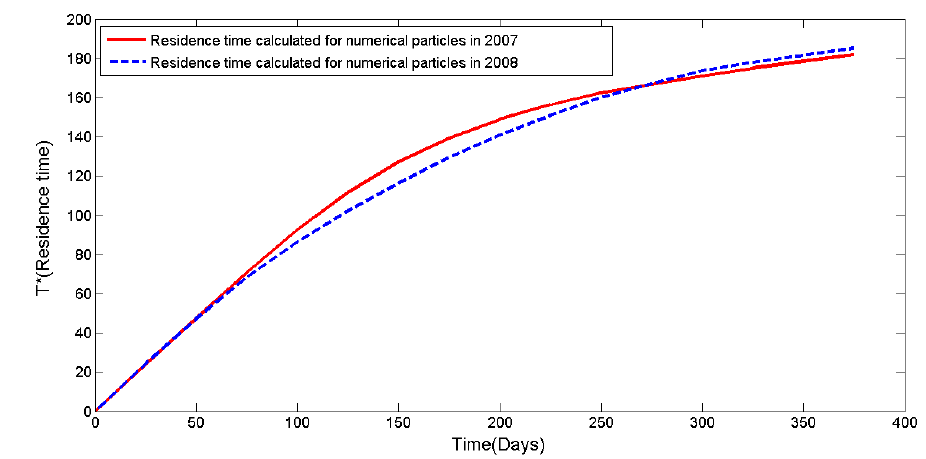
Figure 8. Residence time T* (days) values versus time for numerical particles in 2007 and 2008.